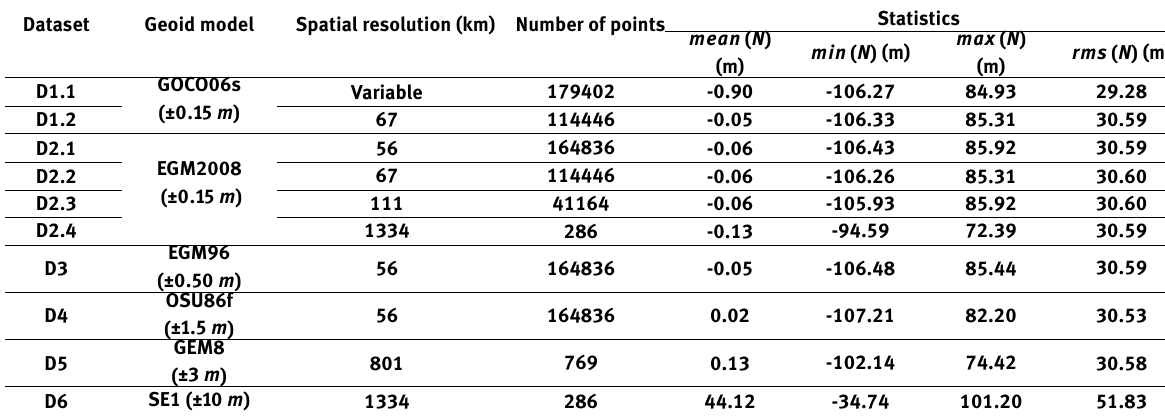
Table 4. Characteristics of the data sets used Dataset